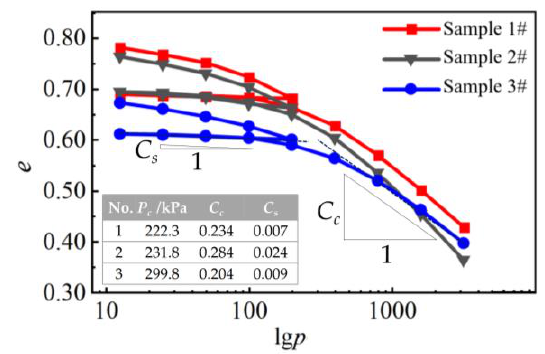
Figure 5. The e -lg p curves obtained from the oedometer test.